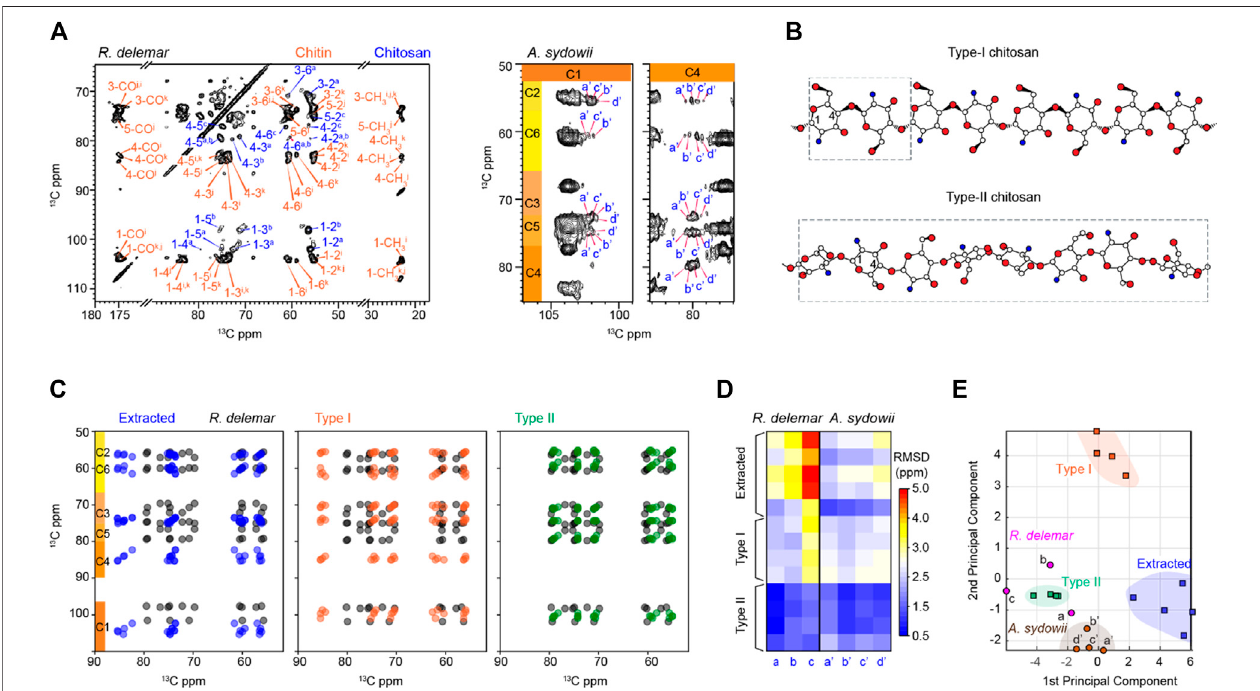
FIGURE 6 | R. delemar and A. sydowii cell walls are rich in chitosan. (A) Representative 2D 13 C- 13 C CORD spectrum of R. delemar and A. sydowii cells showing many sets of chitosan signals (blue). (B) Representative structures ofType-I and Type-II chitosan molecules. Nitrogen (blue), oxygen (red), and carbon (white) atoms are shownbuthydrogenatomsarenotincludedforsimplicity.Therepeatingunitsareshownindashlineboxes.Structureschemesareadaptedfrom(Okuyamaetal.,2000). (C) Simulatedspectraof R.delemar chitosan(black)overlaidwiththeliterature-reportedchitosanformsincludingextractedchitosan (blue;leftpanel) ,Type-Isalts withinorganicacids (orange;middlepanel) ,andType-IIsaltswithinorganicacids (green;rightpanel) . (D) 13 CchemicalshiftRMSDmapforthecomparisonbetween fungal cell wall chitosan ( X -axis) and model samples( Y -axis). The color scale unit is ppm. (E) PCA scores of chitosan. The data analyzed include Type-I (orangesquares) and Type-II (green squares) salts with inorganic acids, extracted chitosan (blue square), as well as the chitosan forms identi fi ed in R. delemar (magenta circles) and A. sydowii (brown circles).